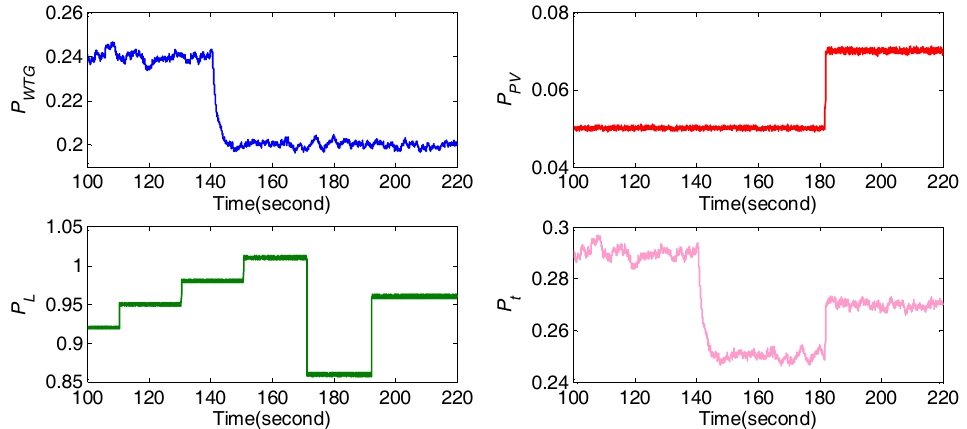
Figure 3. Stochastic powers of WTG (labeled P WTG ), PV (labeled P PV ), demand-side loads (labeled P L ), and the sum of WTG and PV generation (labeled P t ).